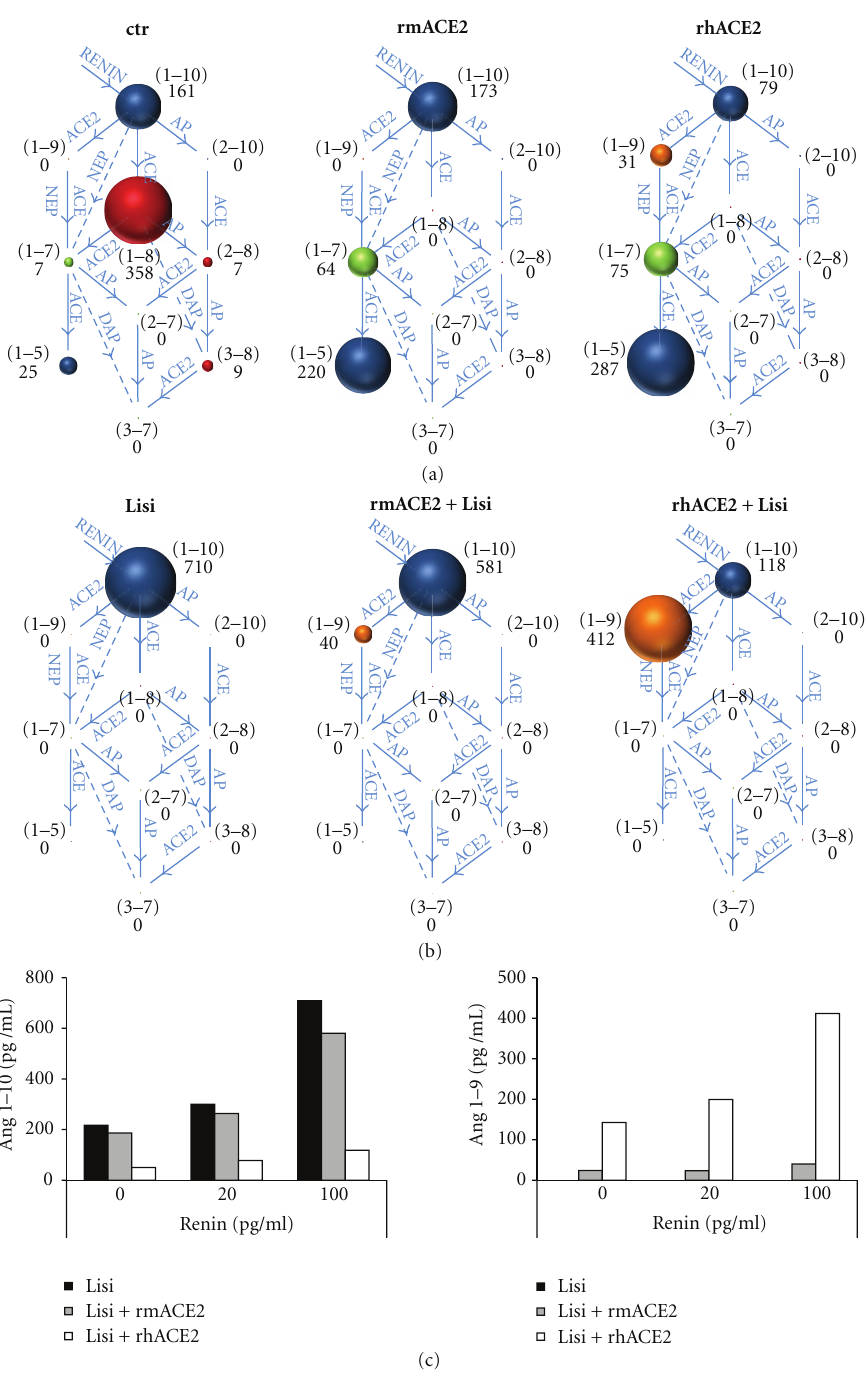
Figure 3: Interference of human and murine ACE2 with the endogenous RAS in human plasma. Anticoagulated plasma samples were incubated at 37 ◦ C in the presence of 100pg/mL recombinant human renin (a, b). rhACE2 or rmACE2 were added as indicated at a final plasma concentration of 5 μ g/mL. RAS-Fingerprints were measured by LC-MS/MS as indicated in Section 2. Samples were incubated in the absence (a) or presence (b) of 10 μ M of the ACE inhibitor Lisinopril. In this figure, the diameter of the spheres reflects the concentration of the respective peptide metabolite, which is also given in pg/mL next to each individual sphere. 0pg/mL indicates concentrations below quantification limits, which are defined by a signal-to-noise ratio below 10. Furthermore, the amino acid sequence of each angiotensin metabolite is schematically given in brackets beside the corresponding sphere. The sequence annotation is based on the decapeptide Angiotensin I (1–10) which is N- or C-terminally cleaved by the indicated proteases. Proteases are illustrated by arrows connecting their substrate and product. AP: aminopeptidases; NEP: neutral endopeptidase; DAP: di-aminopeptidase; ACE: angiotensin-converting enzyme. (c) Indicated concentrations of recombinant human renin were added to Lisinopril-treated plasma samples. Control samples (black bars), rmACE2- (grey bars), and rhACE2- (white bars) treated samples were subjected to RAS-Fingerprinting, and resulting concentrations for Ang 1–10 (left) and Ang 1–9 (right) are given in